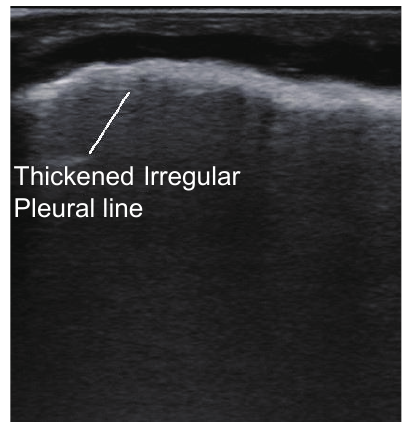
Figure 4 Thickened (> 0.5 mm) and irregular pleural line with